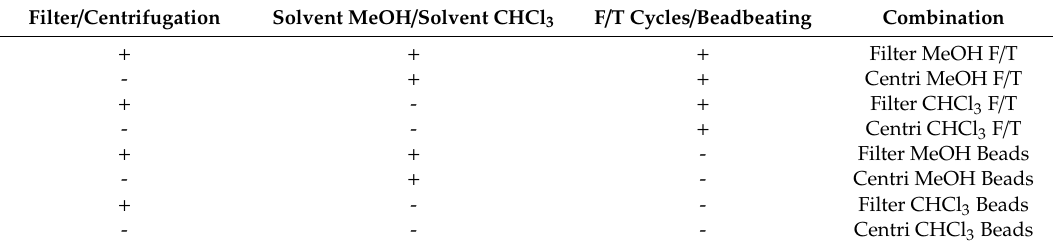
Table 1. Design of experiment (DOE) of the eight sample preparations, each investigated in triplicate, with di ff ering cell retrieval systems (filter or centrifugation), quenching and extraction